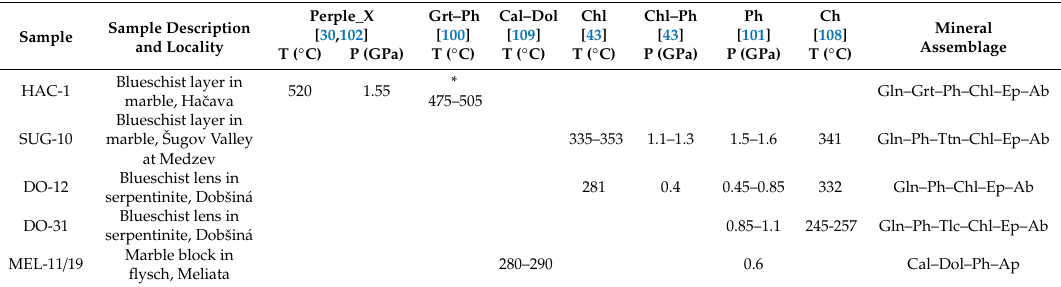
Table 10. P–T estimates based on combined thermodynamic modelling and the geothermobarometry of B ô rka Unit rocks.